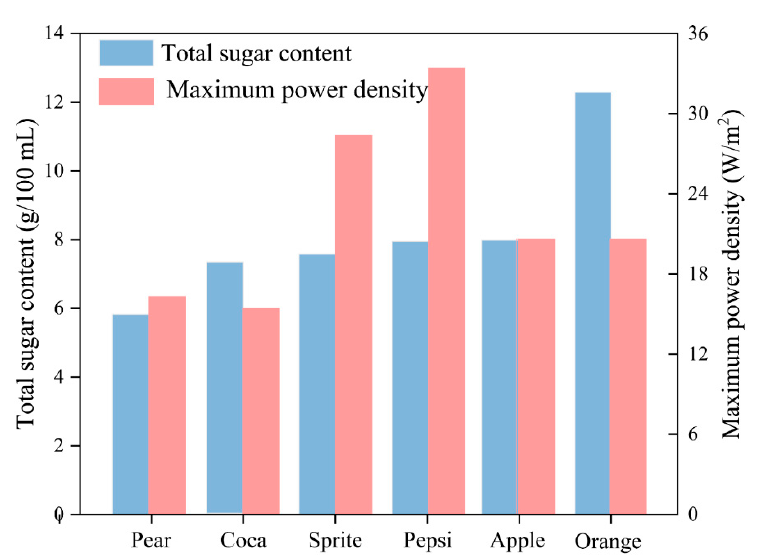
Figure 7. Power densities of the AFC fueled with different sweet drinks and their total sugar contents.